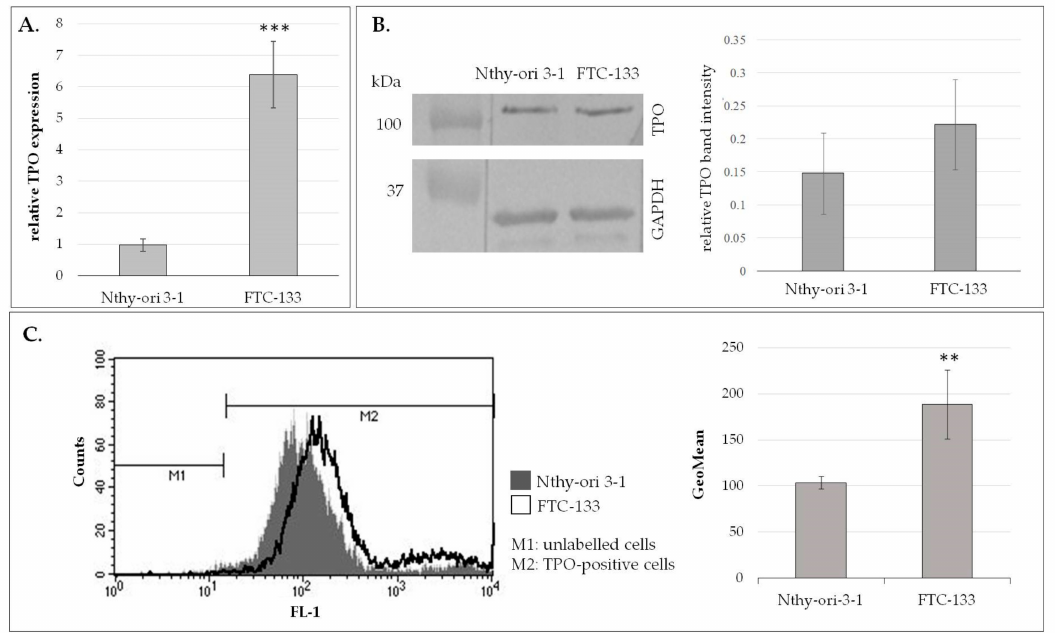
Figure 2. TPO expression in Nthy-ori 3-1 and FTC-133 target cells. ( A ) TPO mRNA level normalized to 18S rRNA reference gene. ( B ) Immunodetection of TPO (left panel) and the intensity of TPO bands (right panel). The protein extracts were separated on 10% SDS-PAGE, blotted onto a PVDF membrane, and probed with the specific antibodies against TPO and GAPDH (loading control). Molecular mass was verified using the protein standard (Bio-Rad). The intensity of TPO bands was measured densitometrically and normalized to the corresponding GAPDH bands. ( C ) Flow cytometric analysis of TPO surface expression. The representative histogram plot (left panel) shows TPO-positive cells (M2) determined in relation to TPO-negative cells (M1). The bar graph (right panel) presents geometric mean fluorescence (GeoMean). The data are shown as means ± SD obtained from three independent experiments. The di ff erence between the target cells was determined statistically by Student’s t-test, with p ≤ 0.05 considered statistically significant; ** p ≤ 0.01, *** p ≤